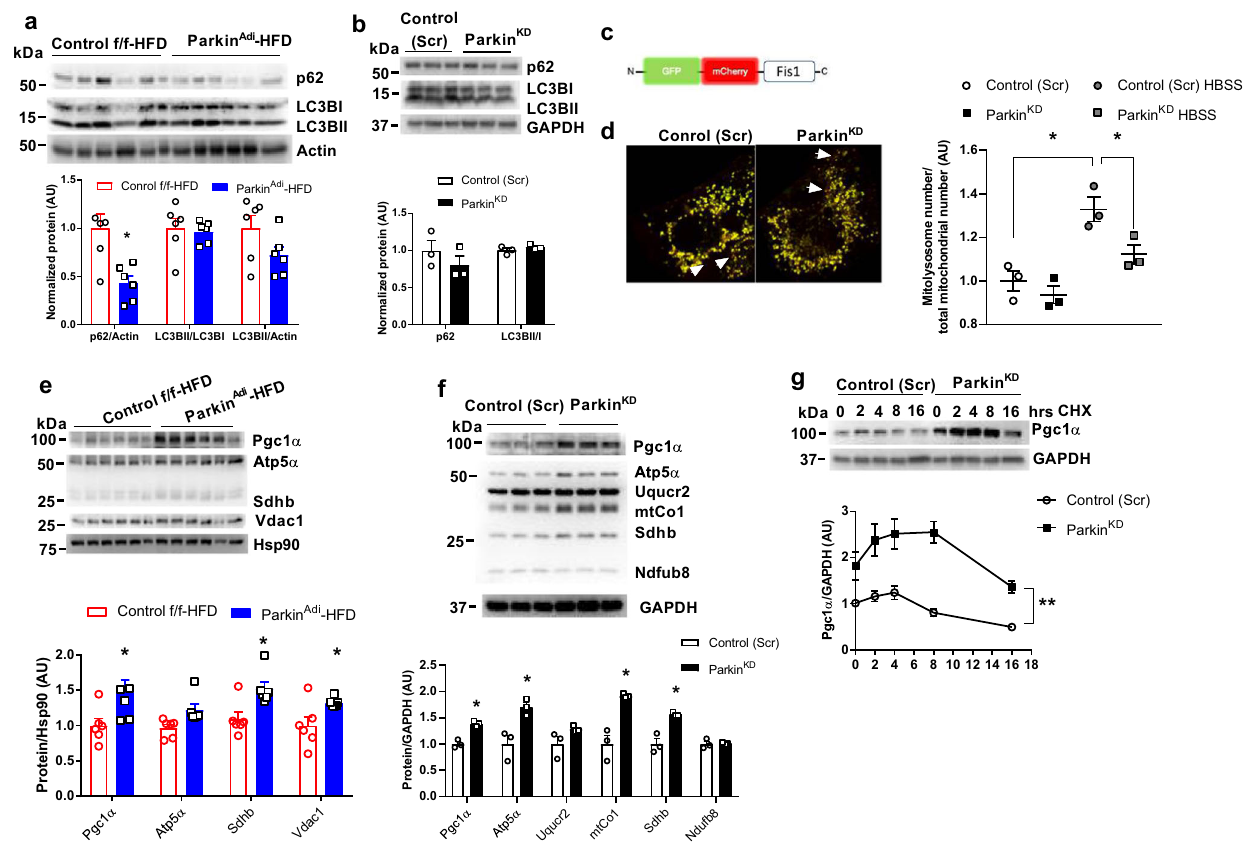
Fig.4|ParkindeletionslightlyimpairsmitophagybutextendedPgc1 α protein stability in adipocytes. a , b Western blot analysis of autophagy markers p62 and LC3 in the eWAT of Control f/f and Parkin Adi mice fed with HFD ( n =6 mice per genotype) and in differentiated adipocytes of Control (Scr) and Parkin KD ( n =3 biological replicate). The bar graphs at the bottom are the densitometric quanti- fi cation of protein level normalized to Actin or GAPDH [Unpaired Student ’ s t test two-tailed. For p62/Actin Control f/f-HFD vs. Parkin Adi -HFD, p =0.0065, 95%CI= − 0.9381to − 0.1982,Rsquared=0.5394]. c AdenoviralGFPandmCherryFis1probe was used for mitophagy quanti fi cation. d Fluorescent microscopy analysis of mitophagy signals in Control (Scr) and Parkin KD adipocytes. The graph on the